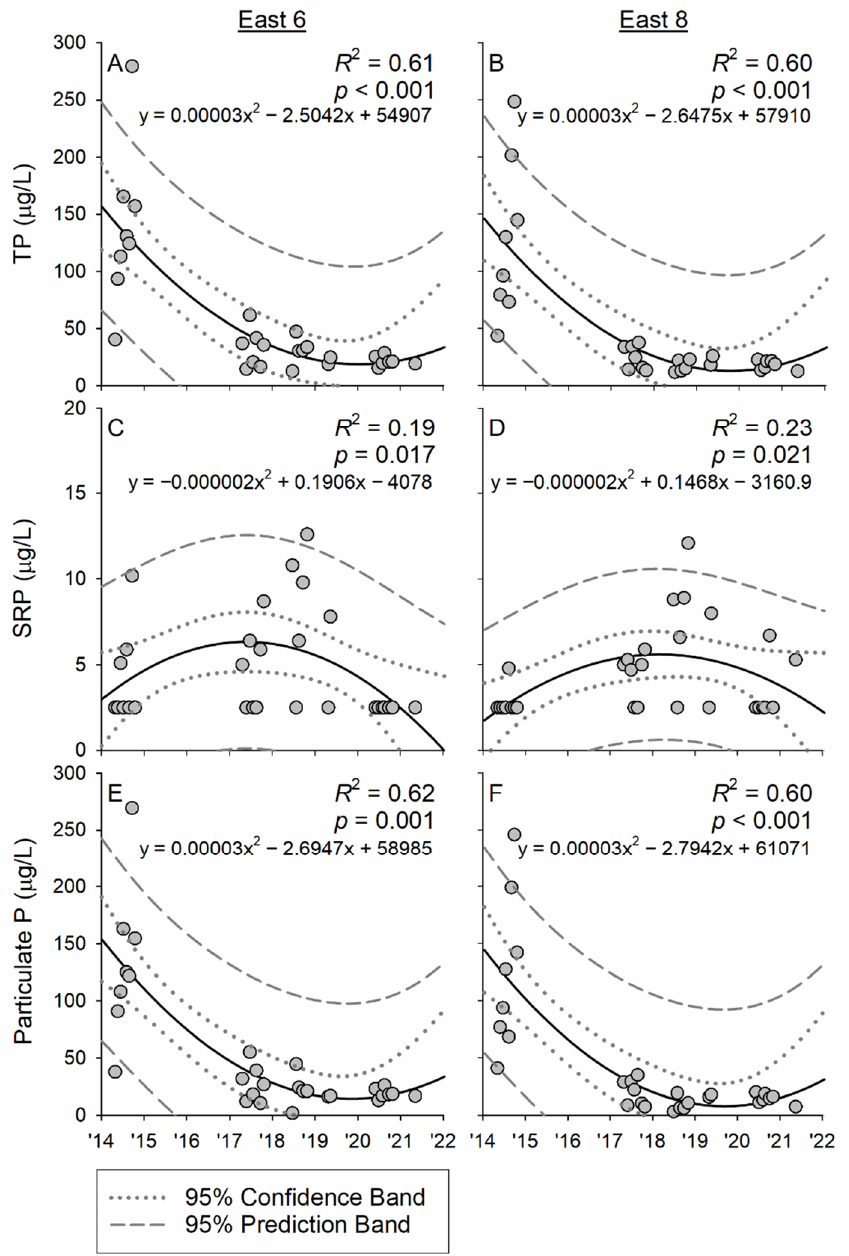
Figure 6. East pond phosphorus regressions of TP ( A , B ), SRP ( C , D ), and particulate P ( E , F ) at sites East 6 ( A , C , E ) and East 8 ( B , D , F ). Legend below E applies to all panels.